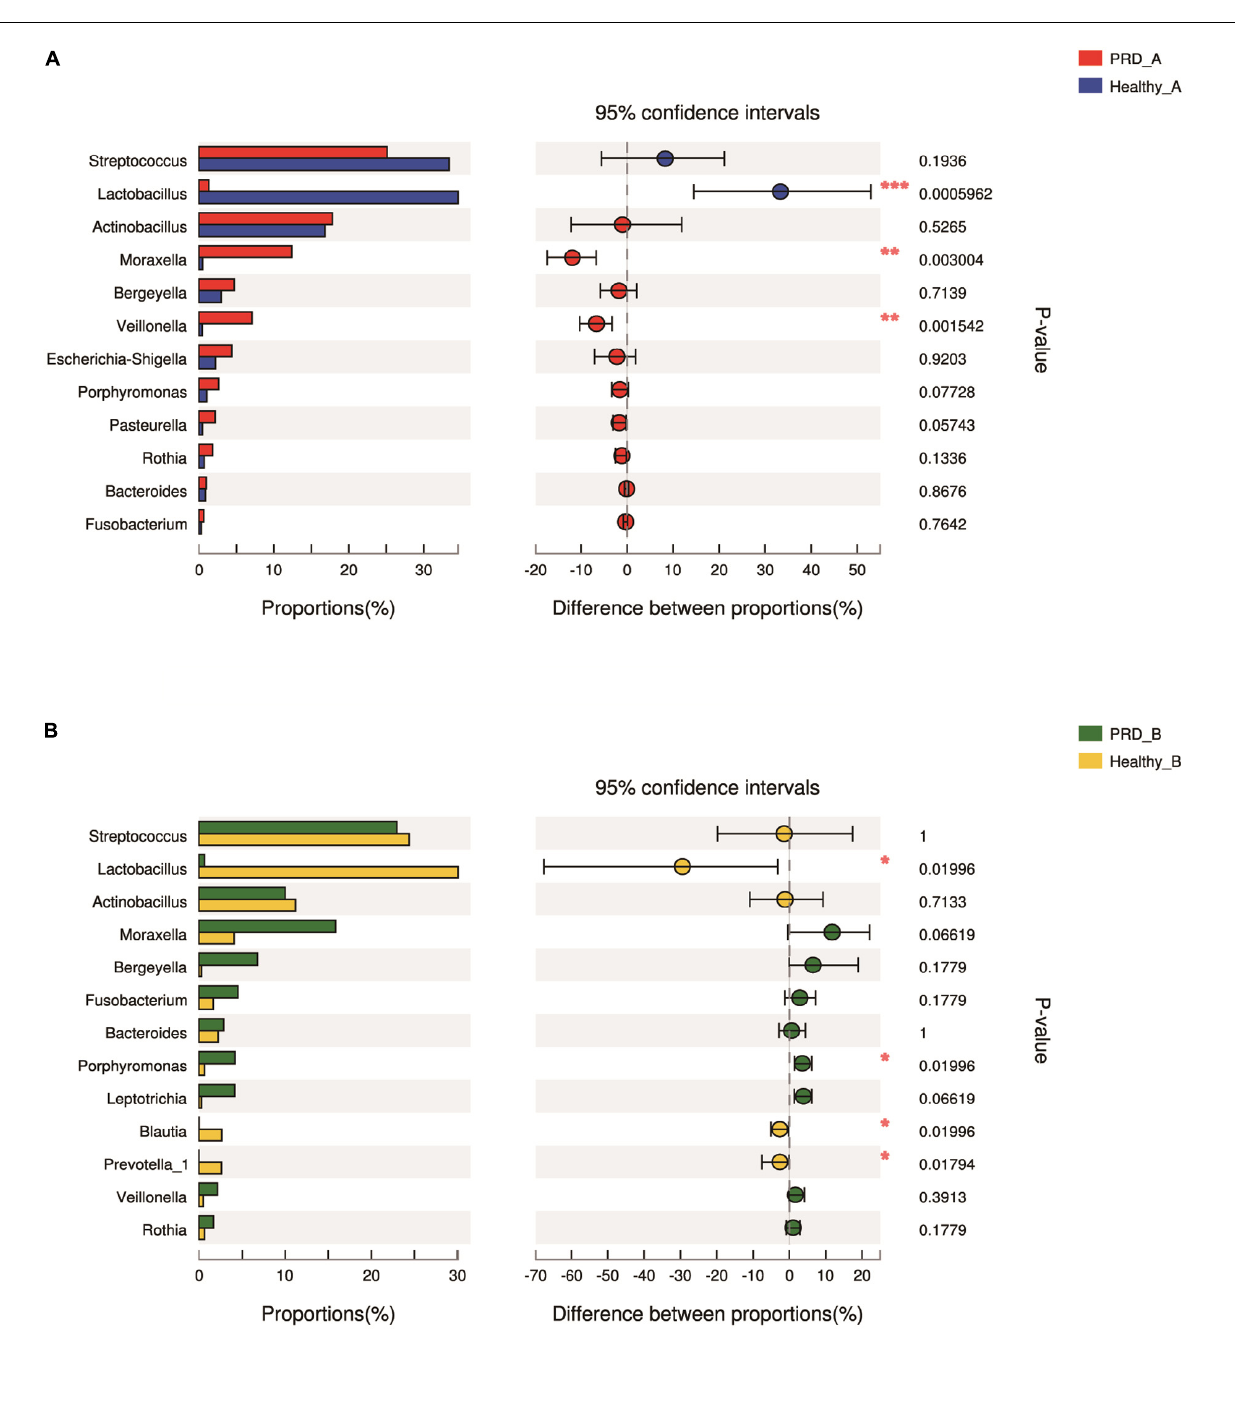
FIGURE 5 | Bar graphs illustrate the differences in predominant bacterial genera between PRD and healthy groups in (A) farm A and (B) farm B, respectively. Data of PRD and control groups are shown as relative abundance (%) of genera in each group. Statistical analysis was performed by the Wilcoxon rank-sum test. ∗ p < 0.05, ∗∗ p < 0.01, and ∗∗∗ p <